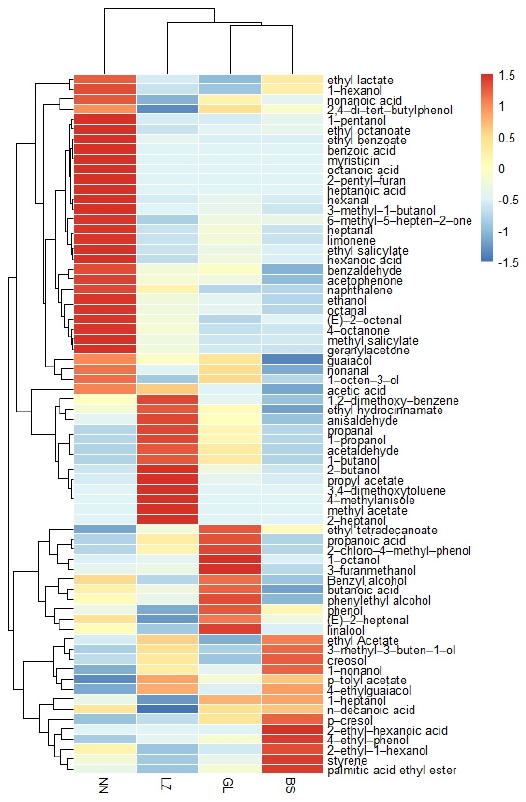
Figure 2. Heatmap analysis of aroma compounds in GFBS.